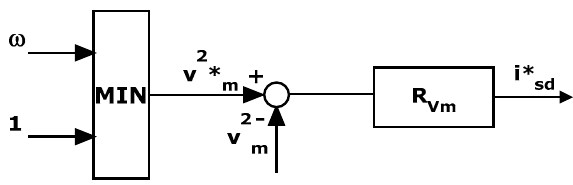
Figure 4. Voltage regulator block diagram. MIN: minimum.